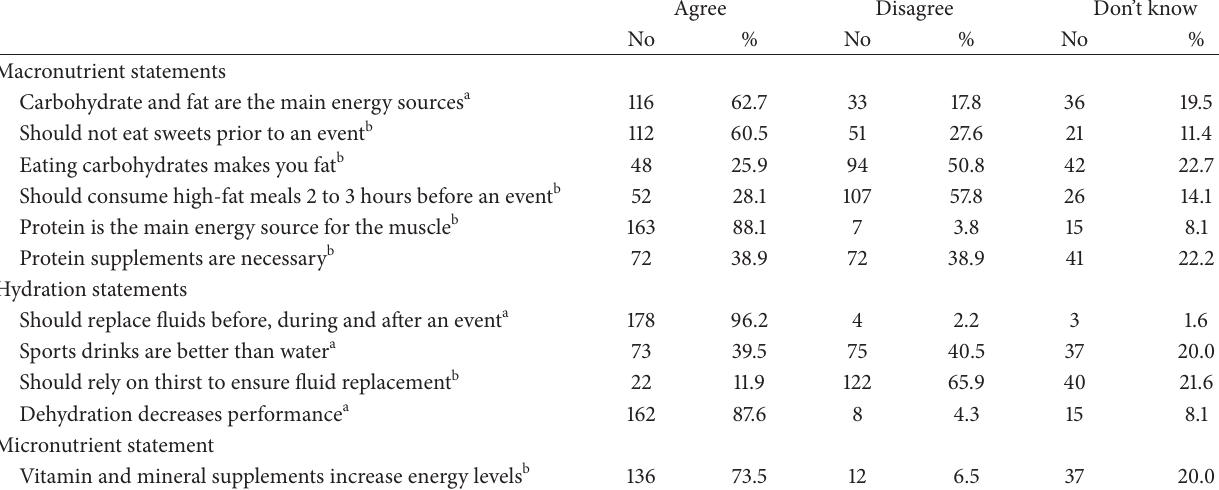
Table 1: Nutrition knowledge of participants.